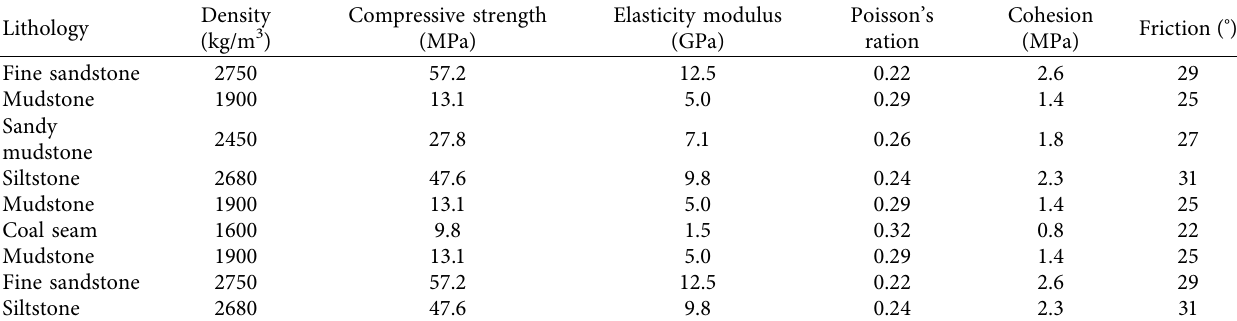
Table 1: The mechanical parameters of the intact rock mass.